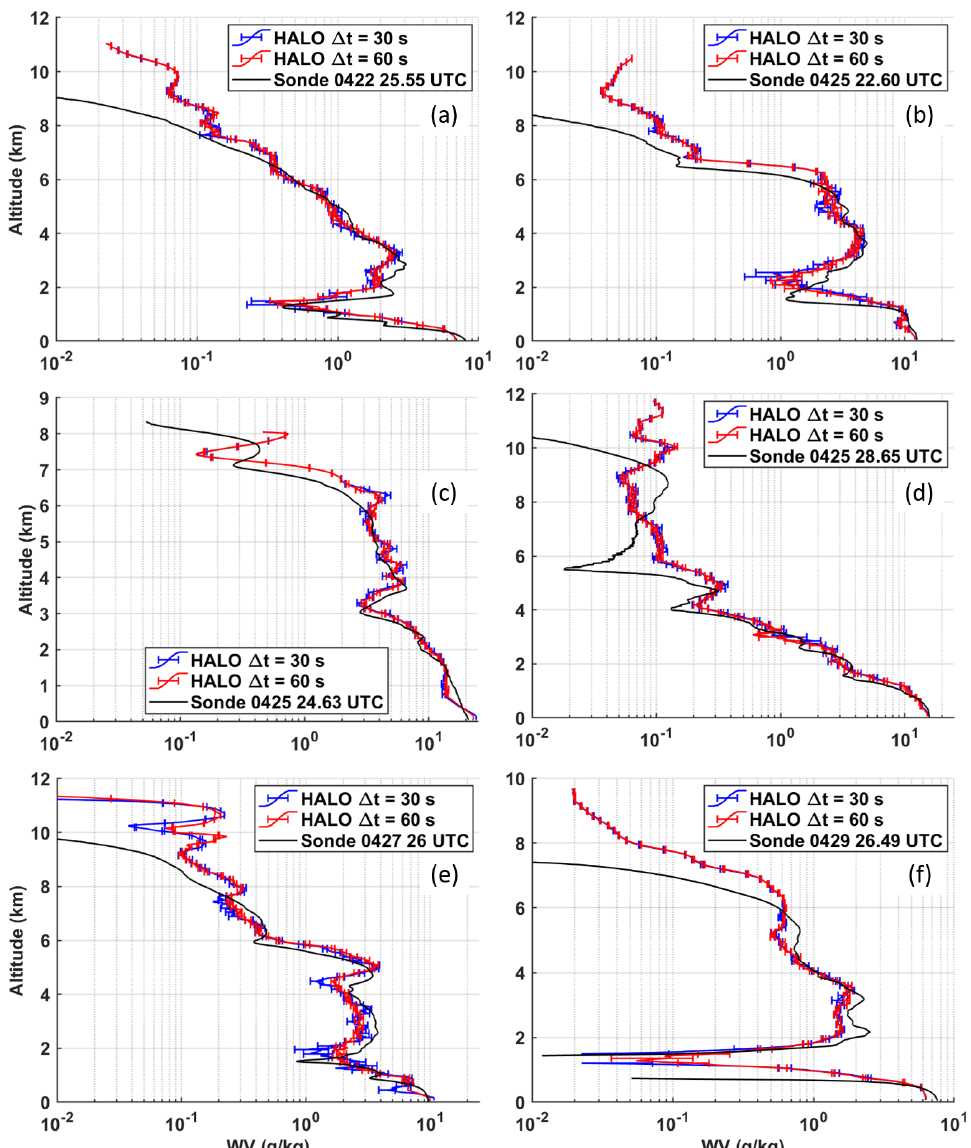
Figure 6. HALO WV mixing ratio profiles with statistical uncertainty bars, and collocated dropsonde profiles for comparison. The bars have been decimated for legibility. The sonde WV sensors had erroneous nonlinear damped responses and thus cannot be used for a rigorous quantitative